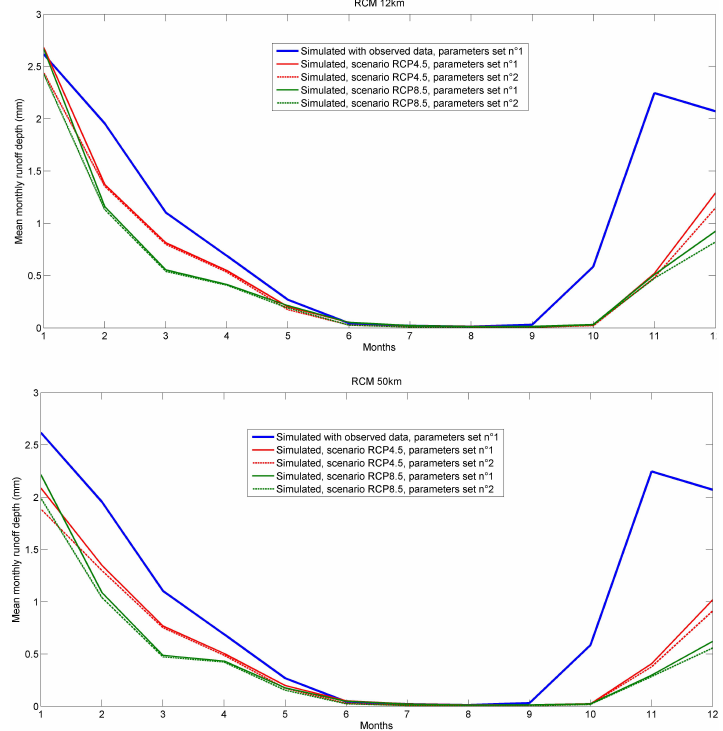
Fig. 15. Projected changes on runoff under scenarios 4.5 and 8.5 for the period 2041–2062 (the parameter set no. 1 is the one obtained when calibrating the hydrological model on all years, the parameters set no. 2 is the set obtained on calibration during dry years).